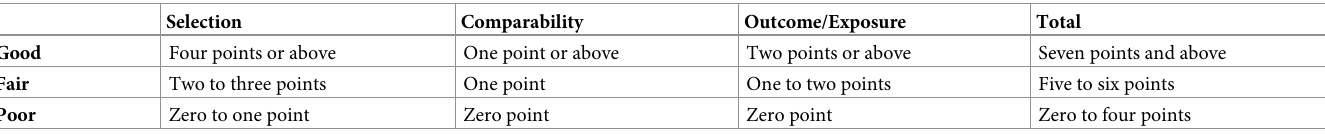
Table 2. Three levels of quality to assess the scores of the selected studies.